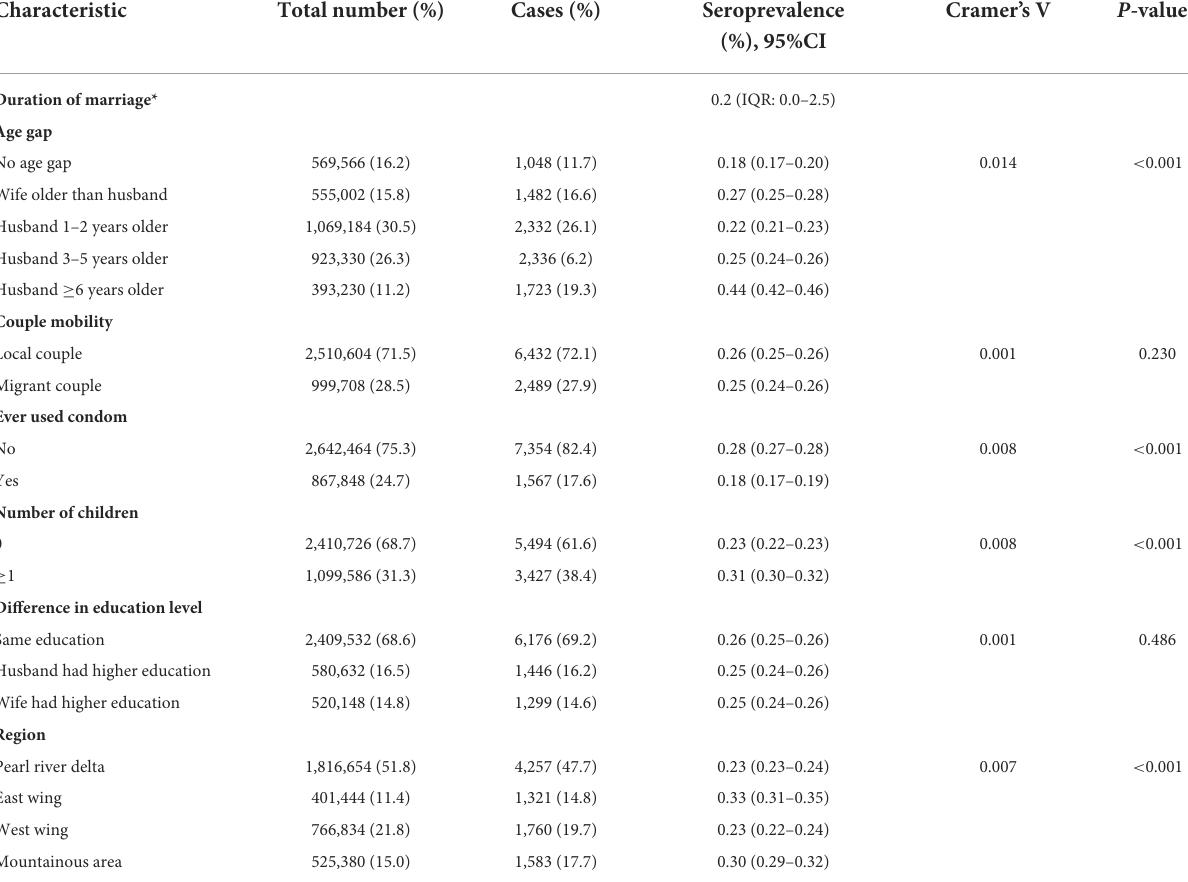
TABLE 2 Couple-level and regional-level factors of heterosexual married individuals who participated in National Free Preconception Health Examination Project in Guangdong Province, China during 2014–2019 ( N = 3,510,312). Characteristic Total number (%) Cases (%) Seroprevalence